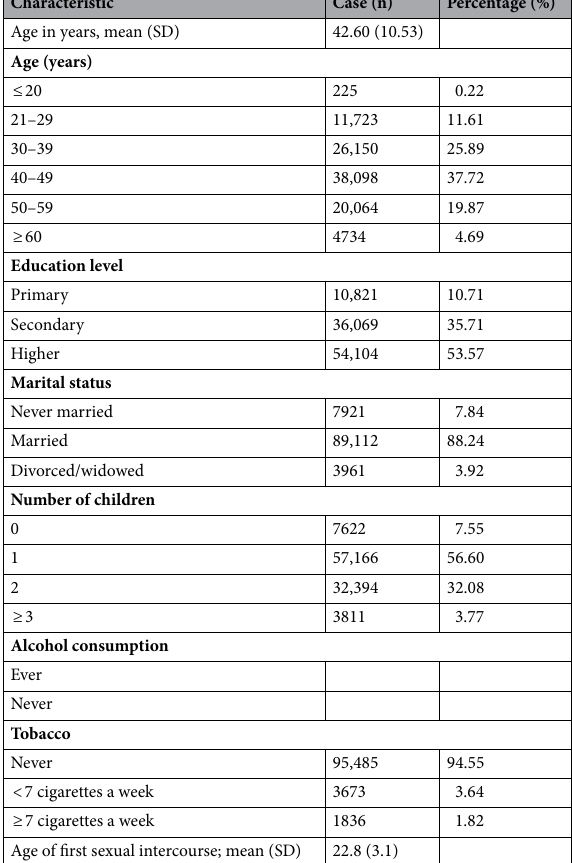
Table 1. Basic characteristics of study participants (N = 100,994).